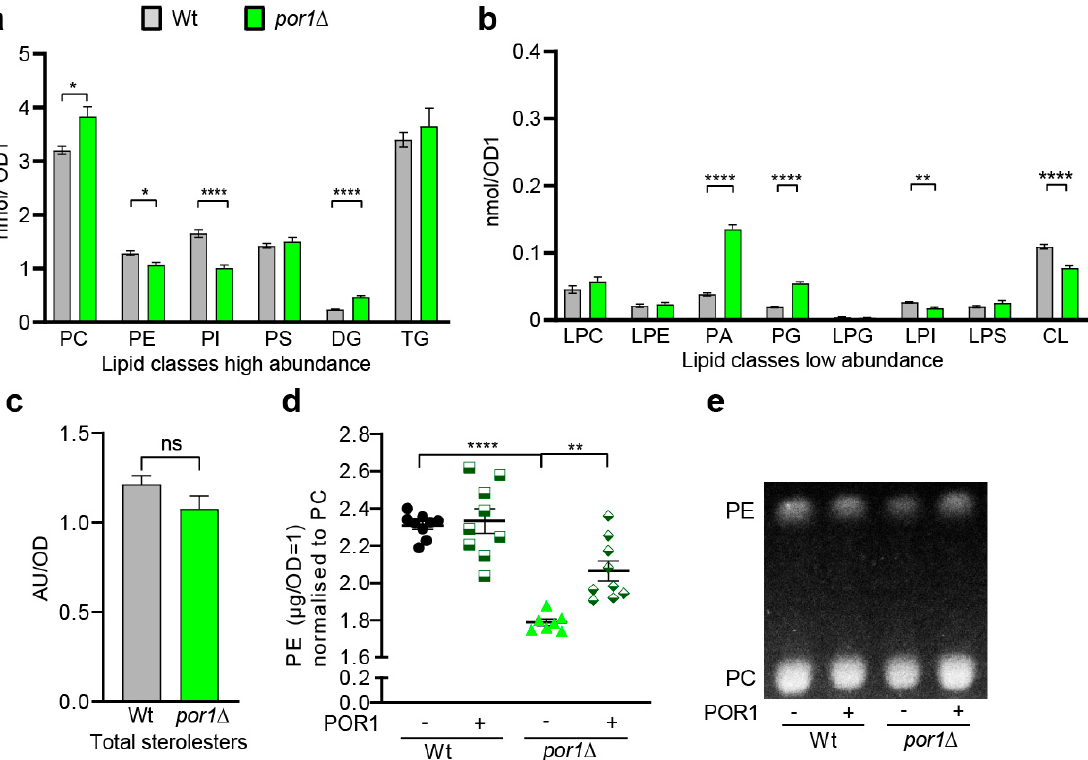
Figure 3. Porin deletion triggers lipidomic changes, including increase in PC and reduction in PE. ( a – c ) Total lipids of wildtype and por1 Δ were detected by shotgun lipidomics. Lipid classes of high abundance ( a ), low abundance ( b ), and sterol esters ( c ) are shown in separate panels. All lipid classes were normalised to OD1 ( n = 8). ( d , e ) Reduction in PE-to-PC ratios in por1 ∆ can be reverted by POR1 re-expression. Quantification of PE-to-PC ratios based on TLC is shown in panel ( d ) ( n ≥ 7) and a representative TLC section is shown in ( e ) . Statistical analysis was performed with GraphPad Prism. To analyse the lipid profile changes selected, paired Welch’s ANOVA for high ( a ) and low ( b ) lipid classes was used. Unpaired t -test was used for ( c ) and Welch’s ANOVA for ( d ). Error bars indicate standard error of the mean (SEM) and asterisks in the figures indicate significant differences, * p < 0.05, ** p < 0.01, **** p < 0.0001.